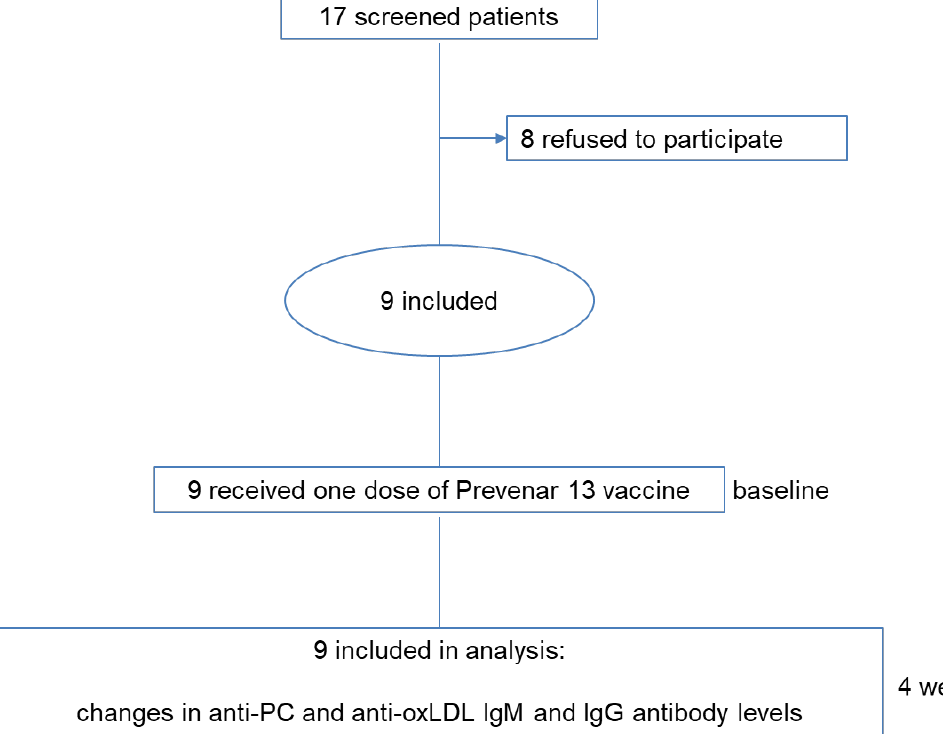
Figure 1. Study design.